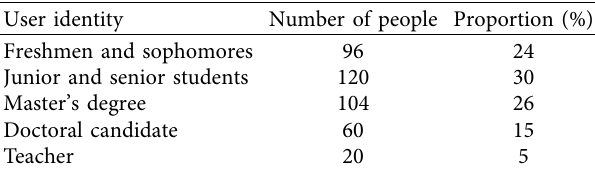
Table 1: Identity analysis of surveyed